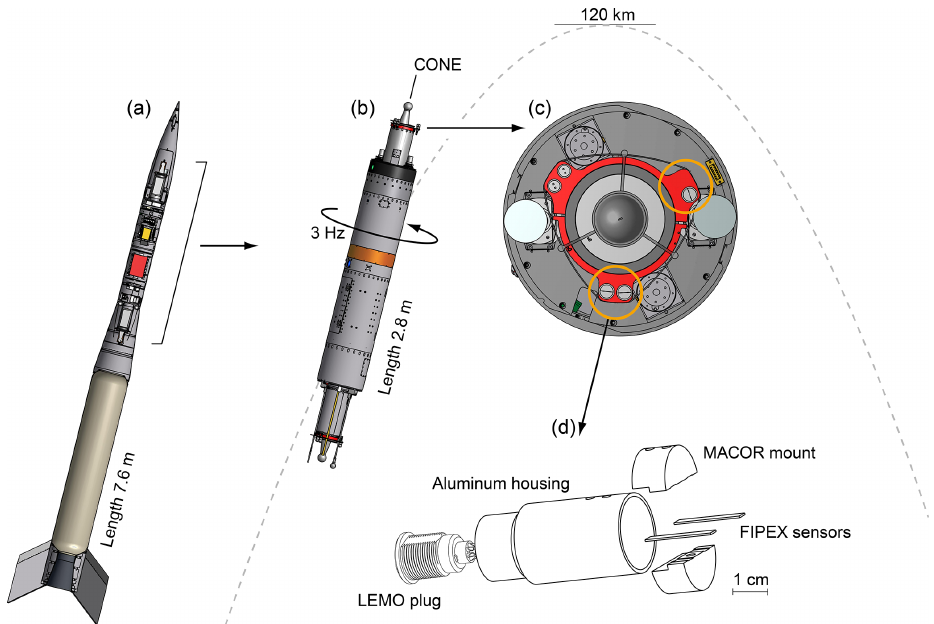
Figure 6. Rocket configuration of the WADIS mission. (a) Total view including motor and nose cone. (b) Spin-stabilized payload with instrument decks on the fore and aft and sketched trajectory. (c) Details of the foredeck with highlighted positions of the FIPEX sensor heads. (d) Assembly of a sensor head with two sensors mounted in an aluminum